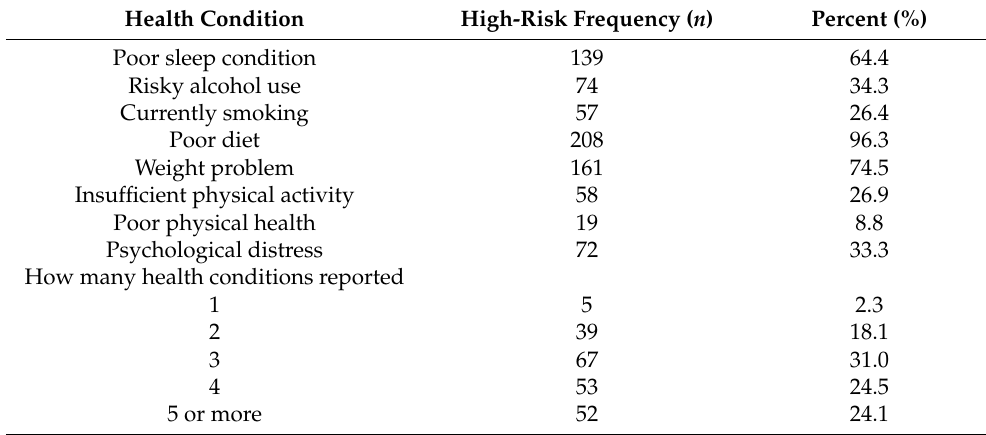
Table 3. Prevalence of risk of health conditions.